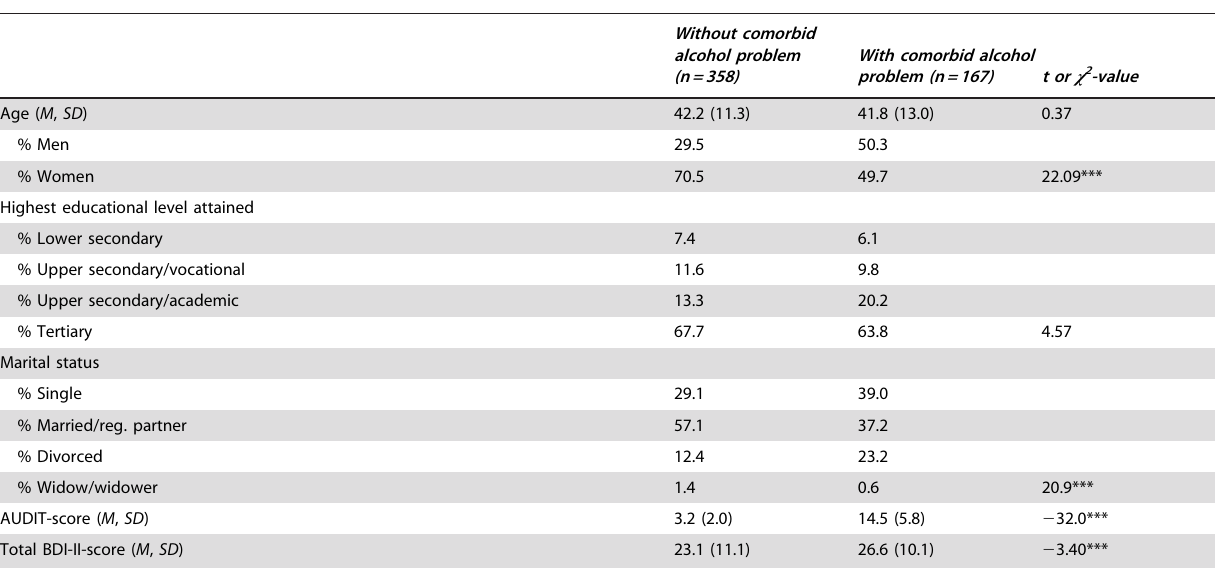
Table 1. Patient demographics, AUDIT-score, and